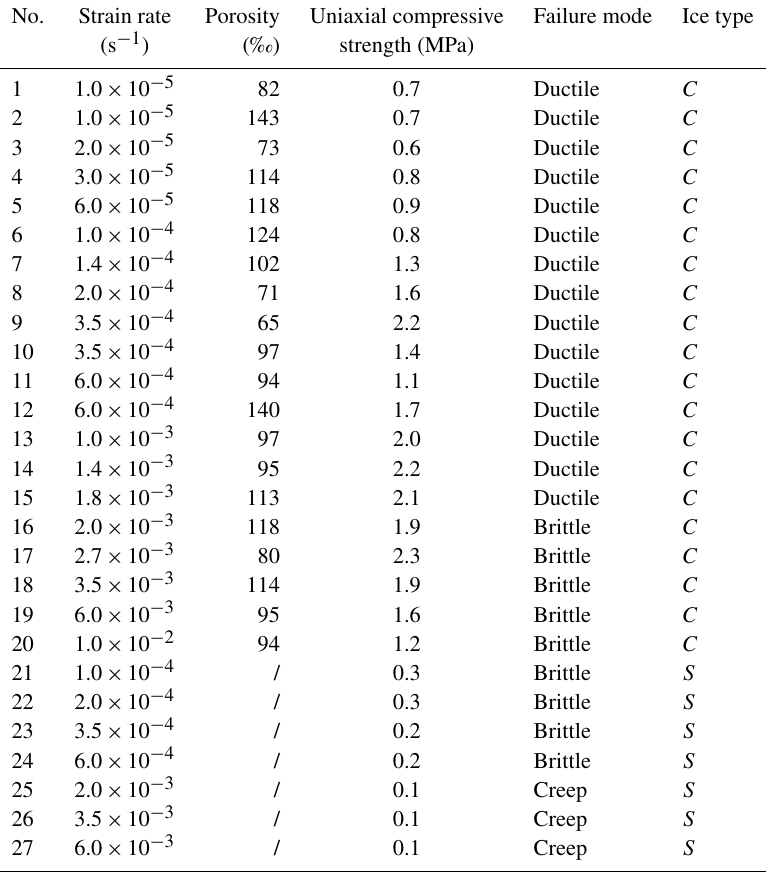
Table A3. Detailed information of horizontally loaded uniaxial compressive strength test samples at the temperature of − 3 ◦ C. No. Strain